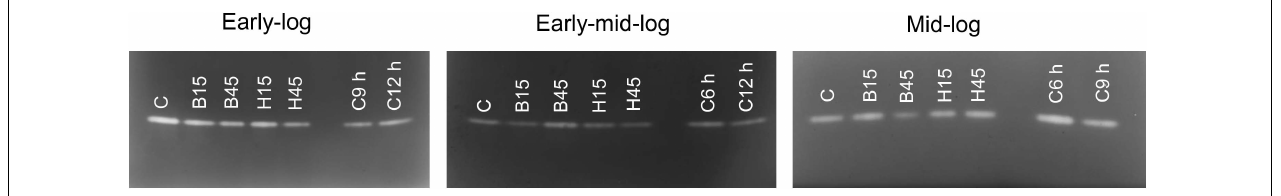
FIGURE 6 | SOD activity of Pseudomonas sp. CMA 6.9 in control treatments (C) and with the herbicides Boral R (cid:13) (B15 and B45) and Heat R (cid:13) (H15 and H45) in the three growth phases indicated. In each of the growth phases, replicates of the other controls were made, with C6 h, 6 h control; C9 h, 9 h control; C12 h, 12 h